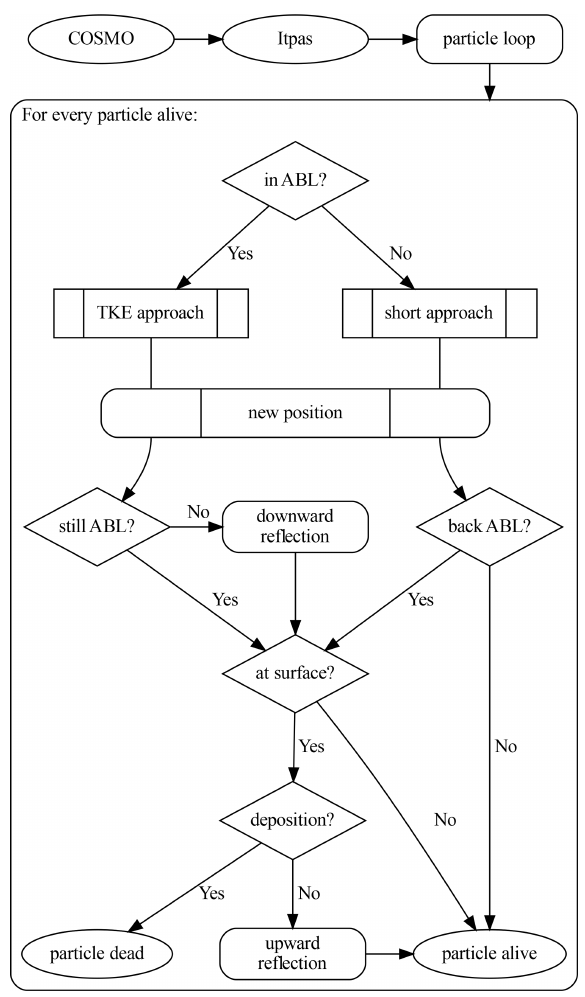
Figure 1. Flow chart of the transport